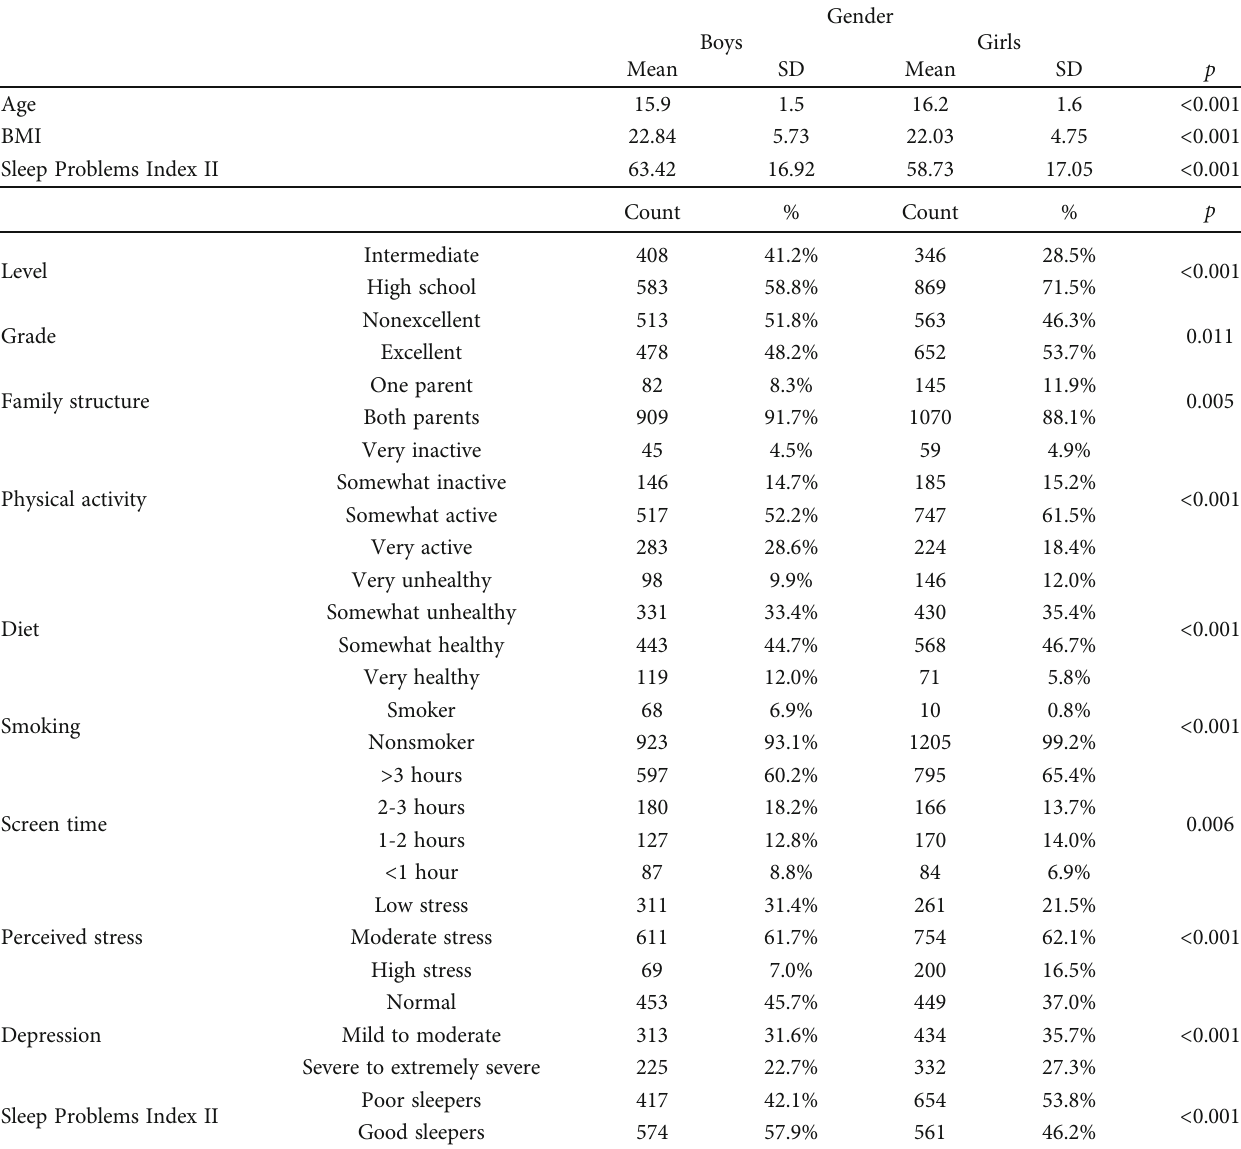
Table 2: Sample characteristics across gender ( n = 2206